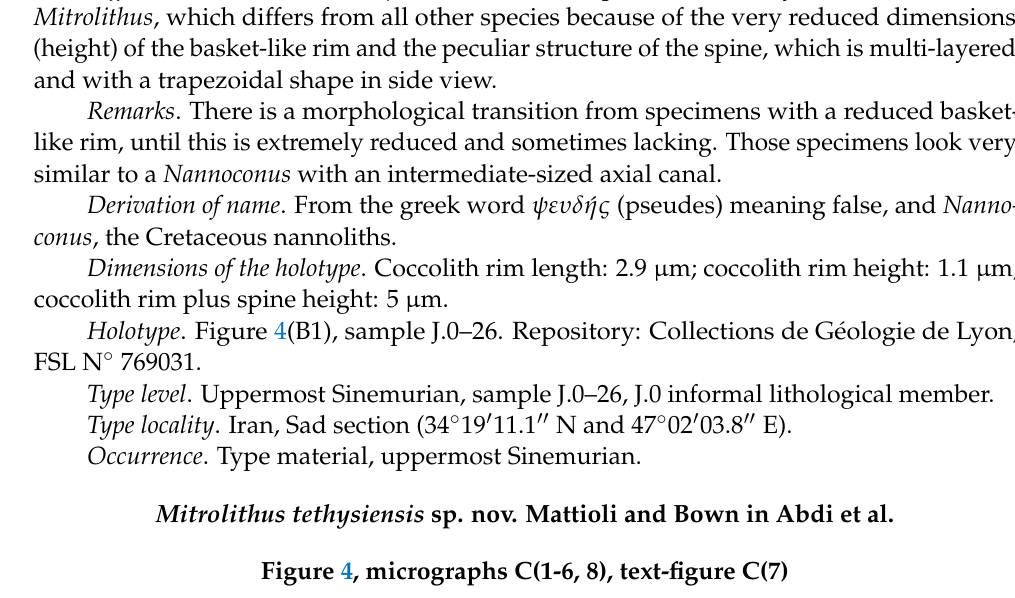
Figure 4, micrographs C(1-6, 8), text-figure C(7)